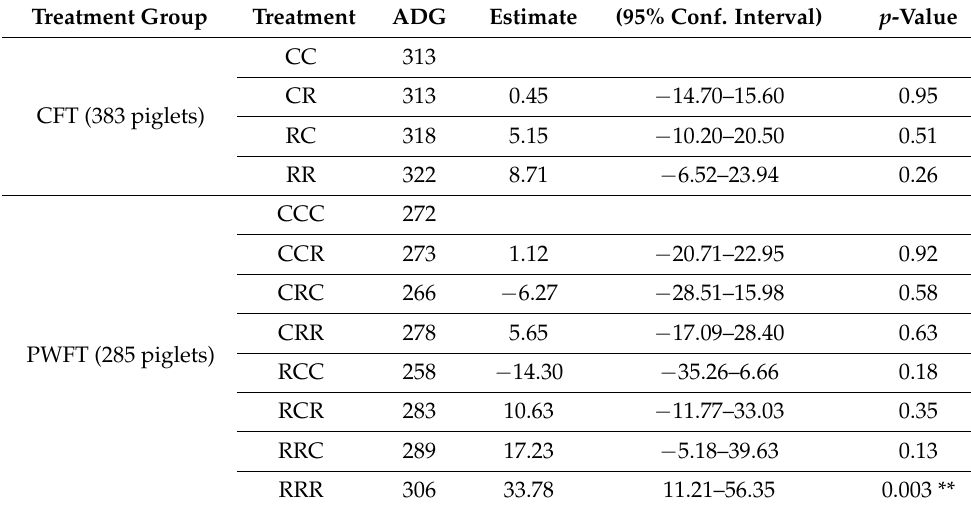
Table 2. Effect of dietary supplementation of resin acid-enriched composition on piglet growth performance (ADG).